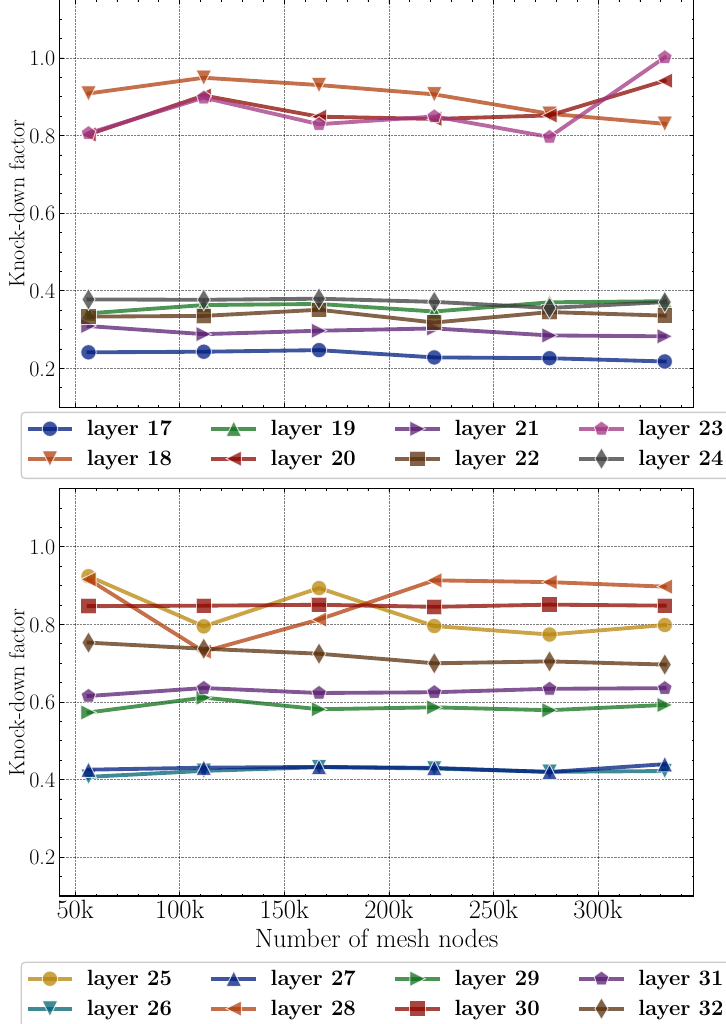
Figure 10. Convergence of KDF according to mesh refinement in the z-direction (layer thickness